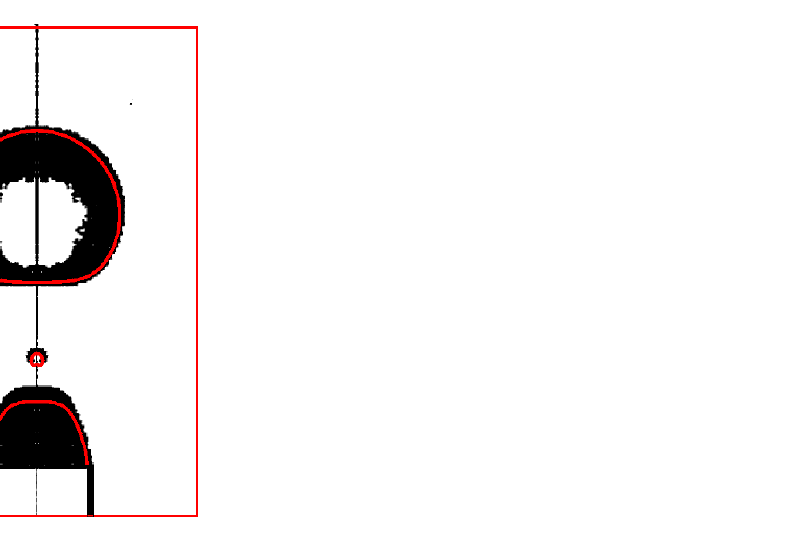
Figure 2. Comparison of present study ( in red ) with respect to the experiments ( in black ) of Zhang